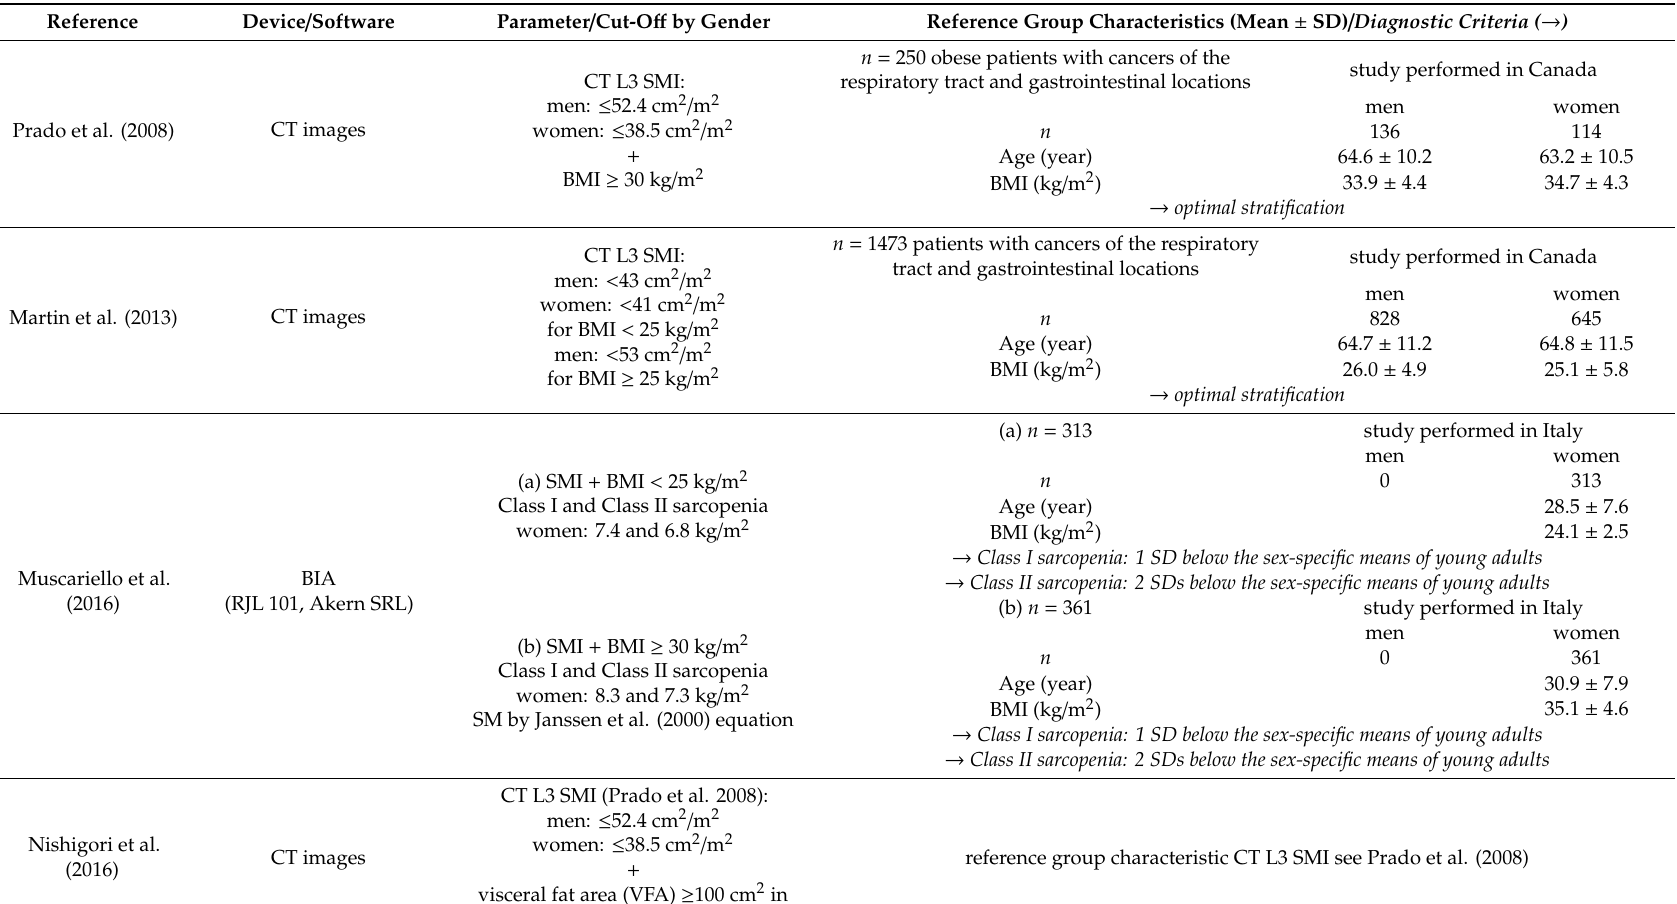
Table 4. Cut-o ff values that combine measures of muscle mass and